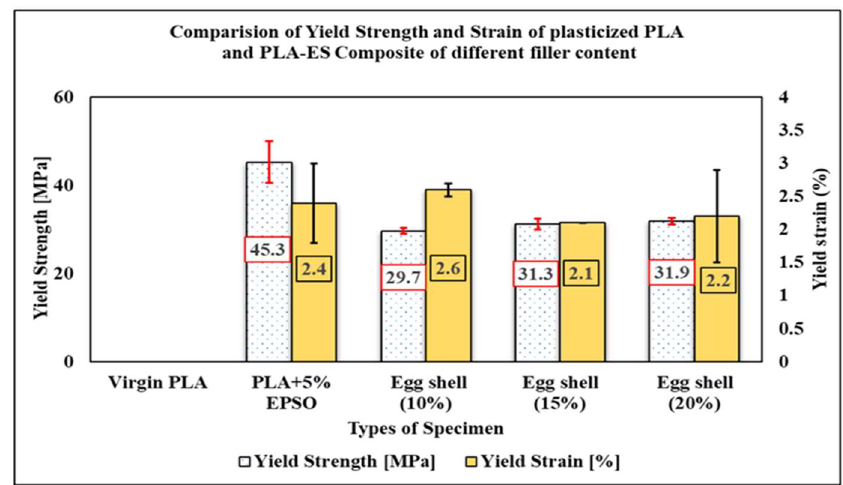
Figure 5. Tensile test result—Yield strength [MPa] and Yield strain [%].